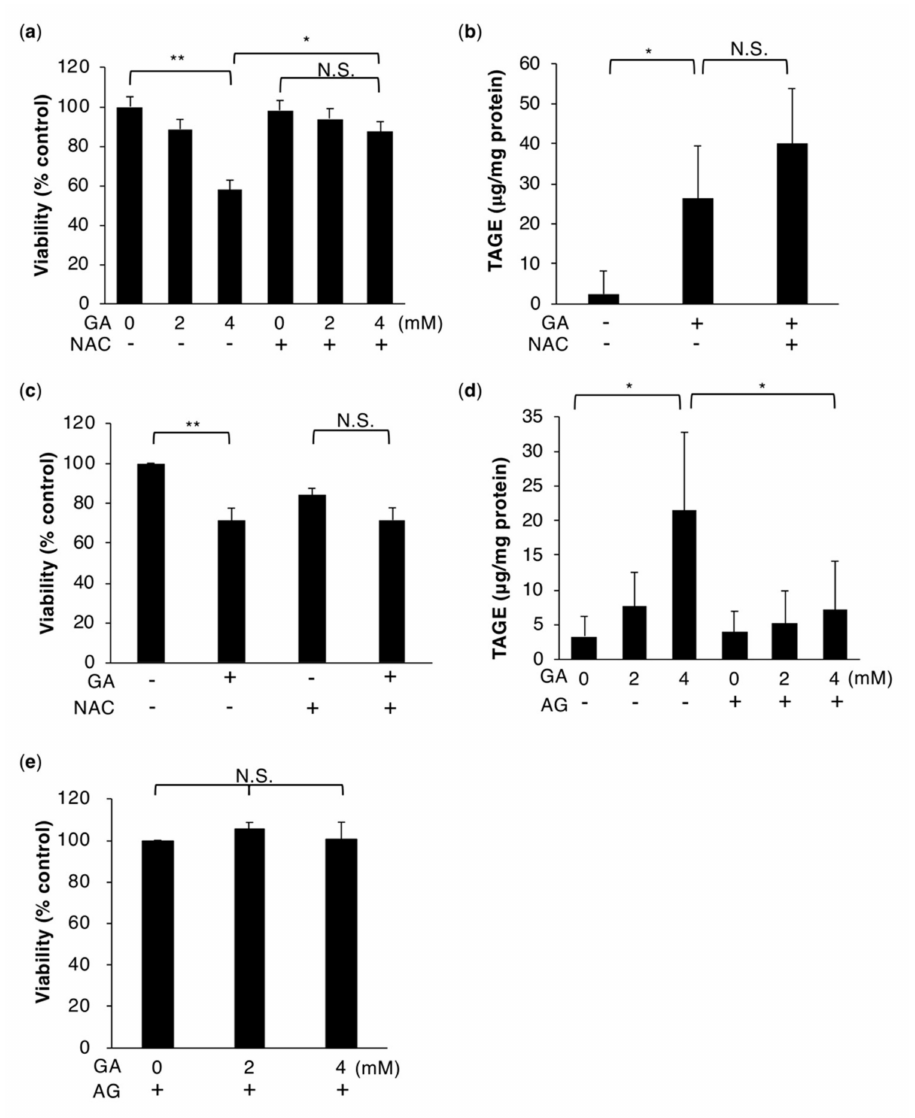
Figure 1. TAGE accumulation-induced hepatocytes death is rescued by the antioxidant NAC. ( a , c ) Cell viability was measured using the CellTiter-Glo luminescent cell viability assay ( n = 3). HepG2 cells ( a ) were treated with 0, 2, or 4 mM GA without or with 5 mM NAC for 24 h. Primary hepatocytes ( c ) were treated with 0 or 4 mM GA without or with 5 mM NAC for 24 h. ( b , d ) Slot blotting was performed to measure intracellular TAGE. ( b ) Cell extracts were prepared from HepG2 cells treated with 0 or 4 mM GA without or with 5 mM NAC for 24 h ( n = 4). ( d ) Cell extracts were prepared from HepG2 cells treated with 0 or 16 mM AG for 2 h followed by 0, 2, or 4 mM GA for 24 h ( n = 3). ( e ) HepG2 cells were treated with 16 mM AG for 2 h followed by 0, 2, or 4 mM GA for 24 h and cell viability was then measured. Results are mean ± S.D. * p < 0.05, ** p < 0.01 and N.S. (Not significant) based on a one-way ANOVA followed by Tukey’s test